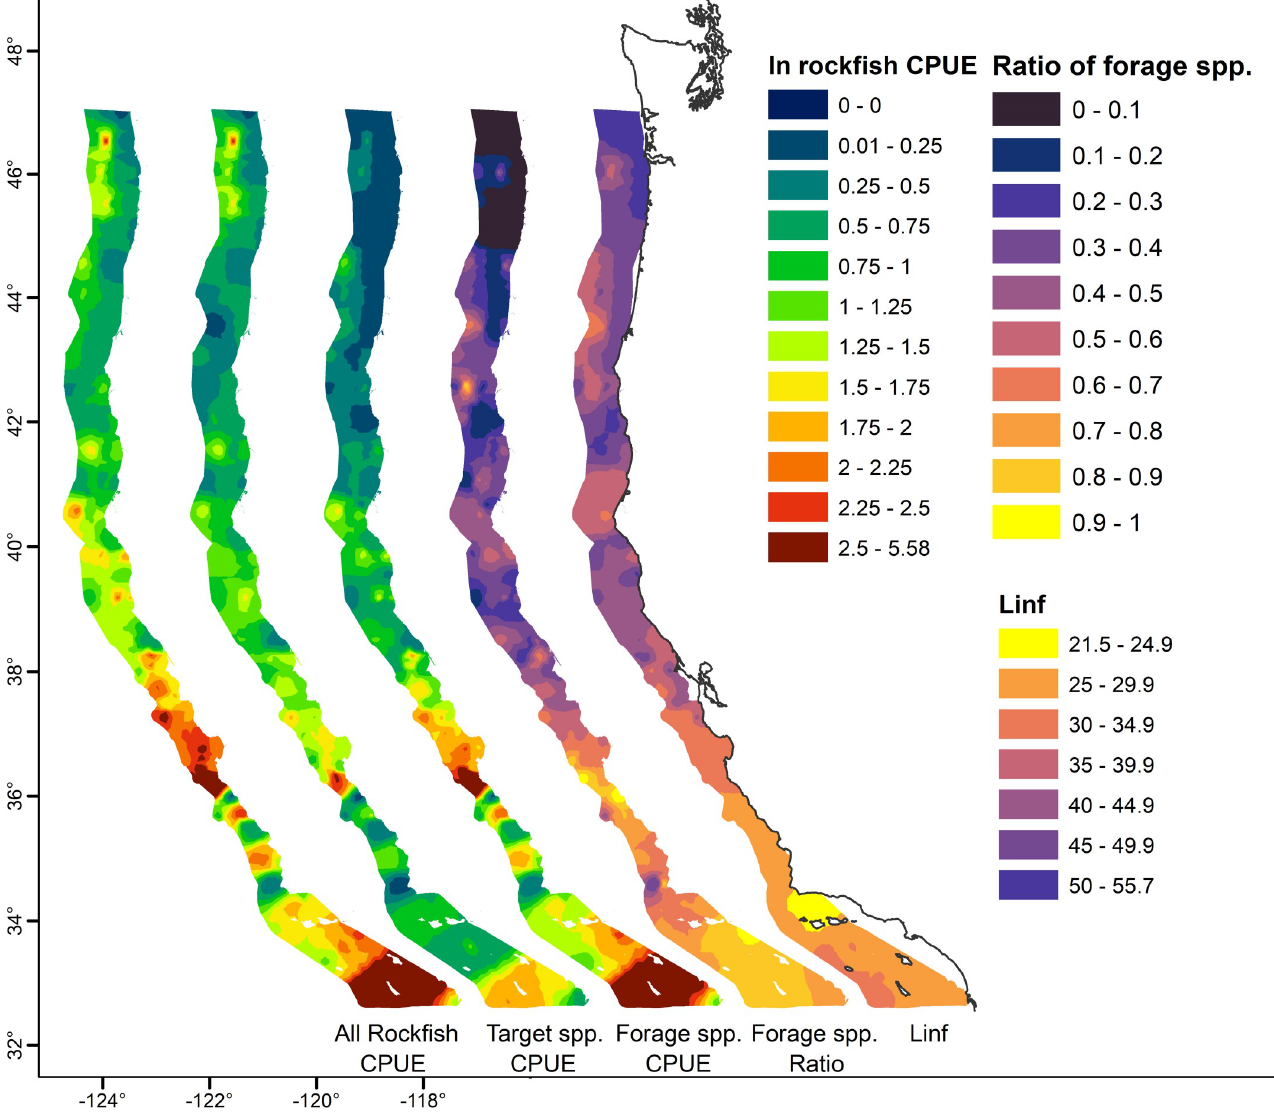
Fig 3. Climatological distribution of pelagic YOY rockfish when target or non-target (forage) species are pooled, showing that the abundance is dominated by non-commercially important taxa in southern waters. Map on far right provides catches weighted by the estimated L infinity (theoretical maximum size) of adults (excluding mixed or unidentified